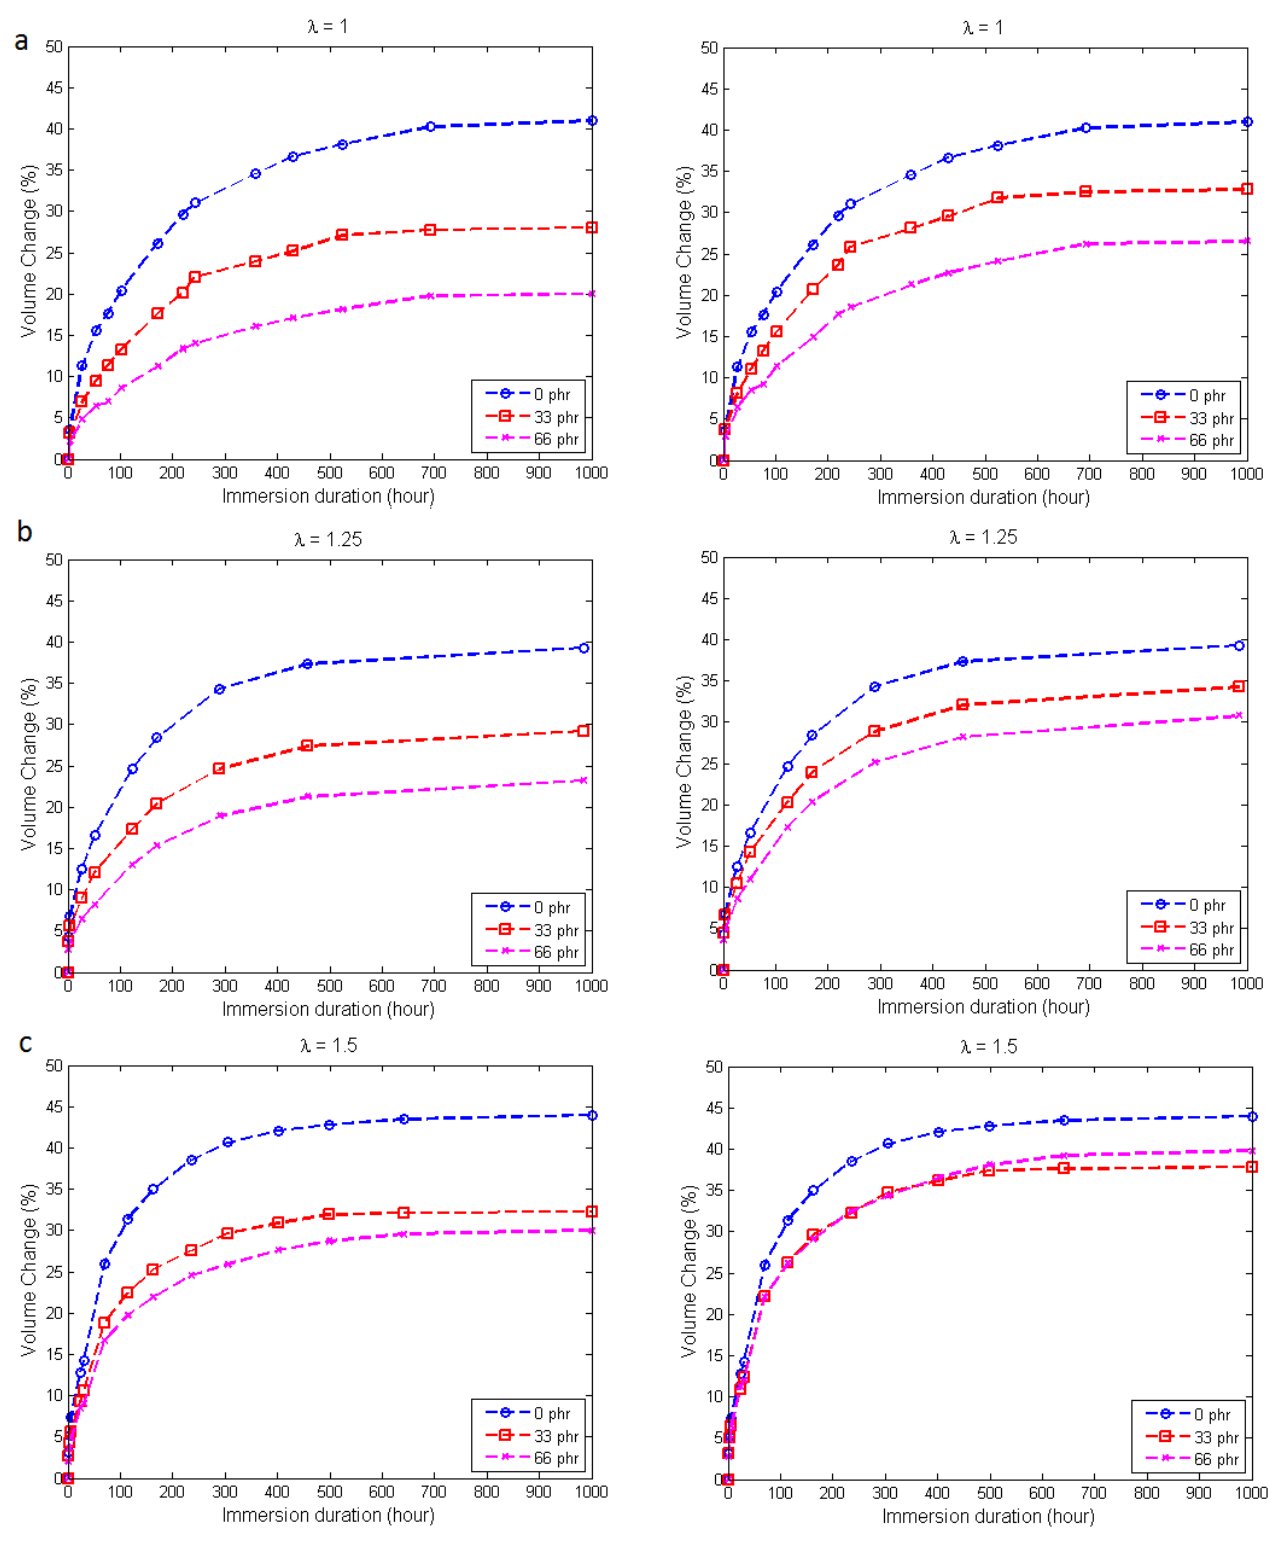
Figure 6. Measured volume change (left) and corrected volume change (right) of specimens for different carbon black contents at ( a ) λ = 1; ( b ) λ = 1.25 and ( c ) λ =